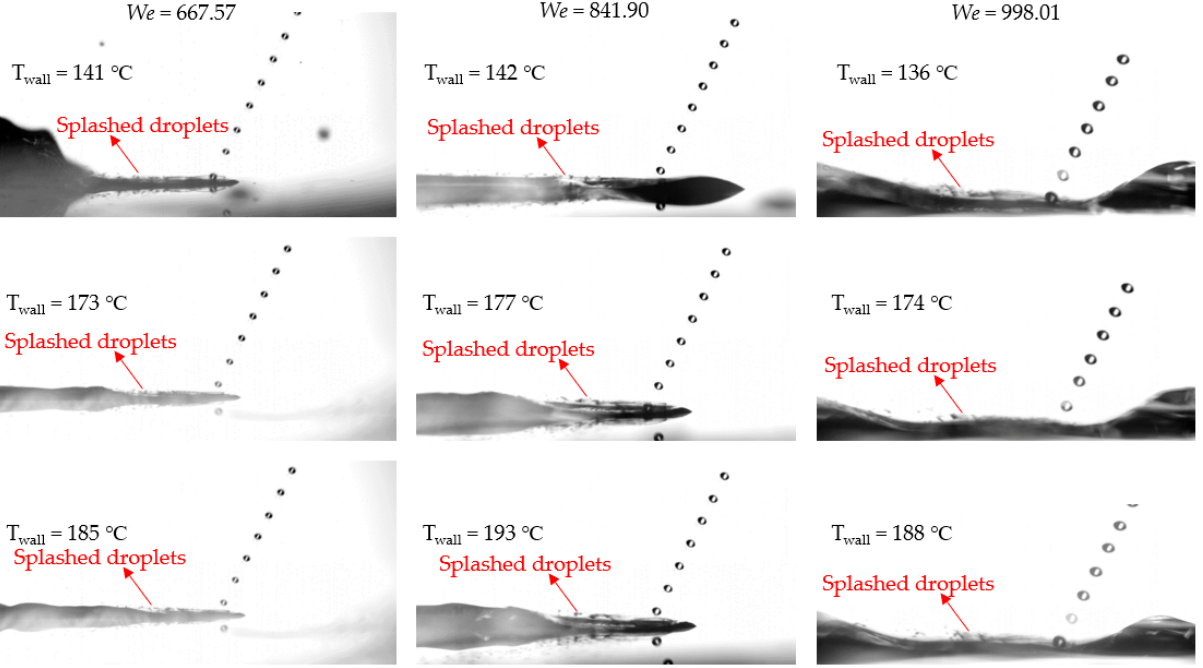
Figure 5. Steady-state hydrodynamic patterns of ethanol droplet train impingement on the target glass surface at different Weber numbers for the surface temperature values of 135.00 °C to 200.00 °C. A Supplementary Material (Video S1) can be seen as well.